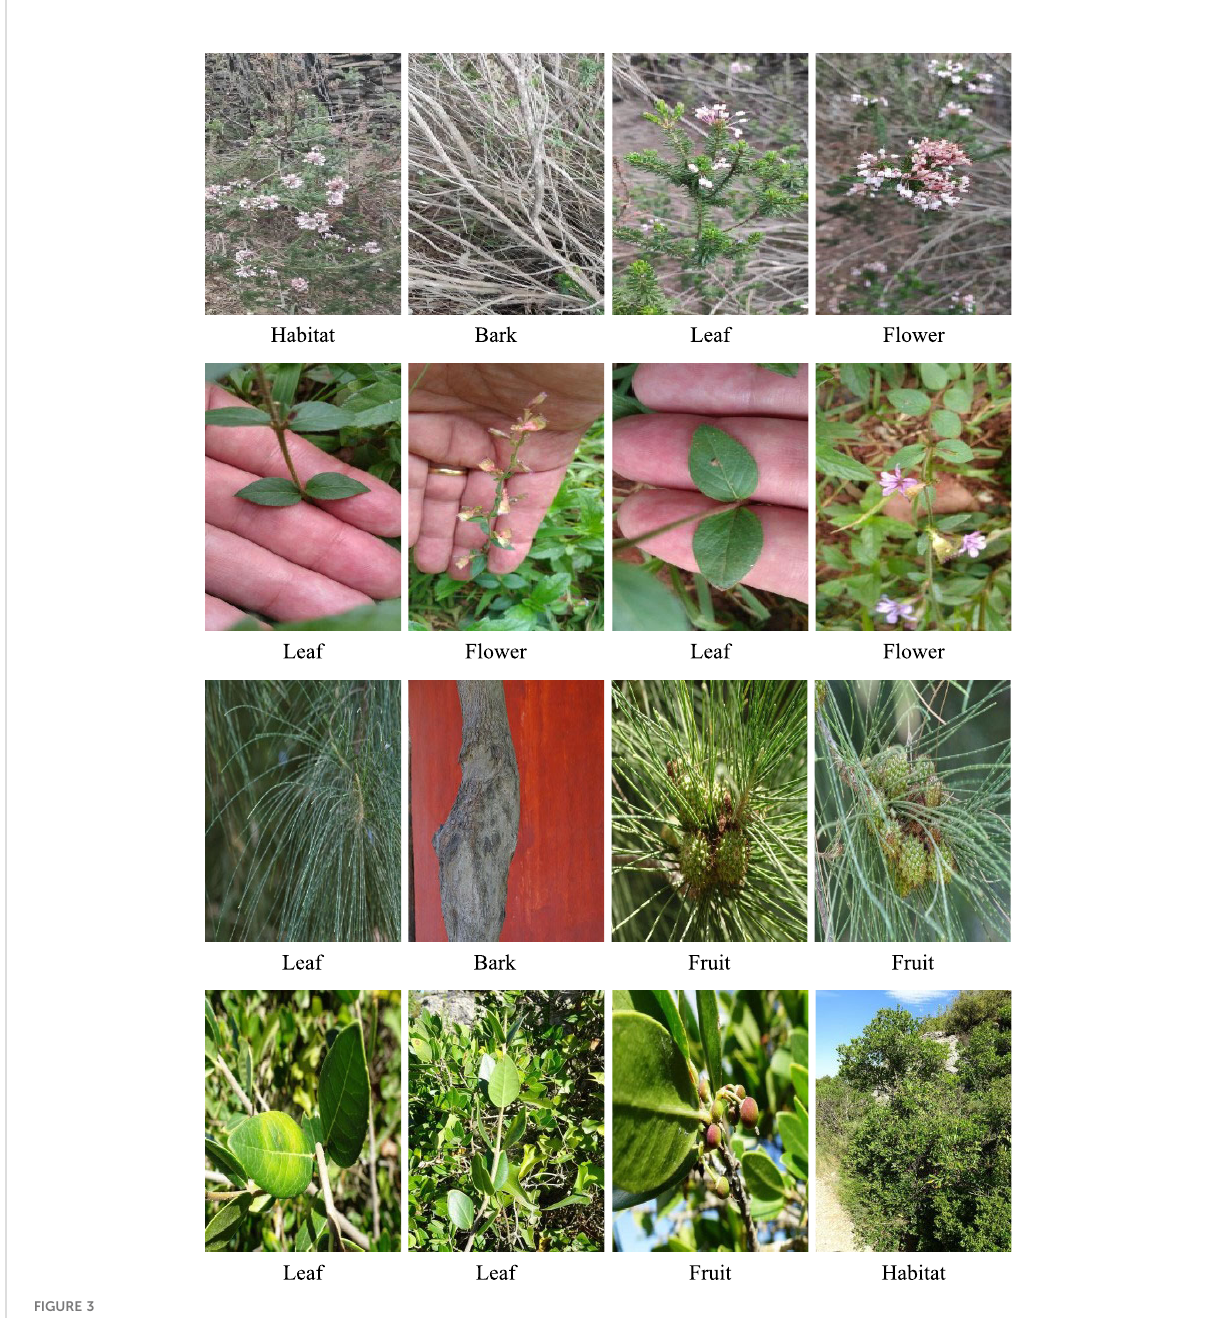
FIGURE 3 Different interests or organs in PlantCLEF2022 testing